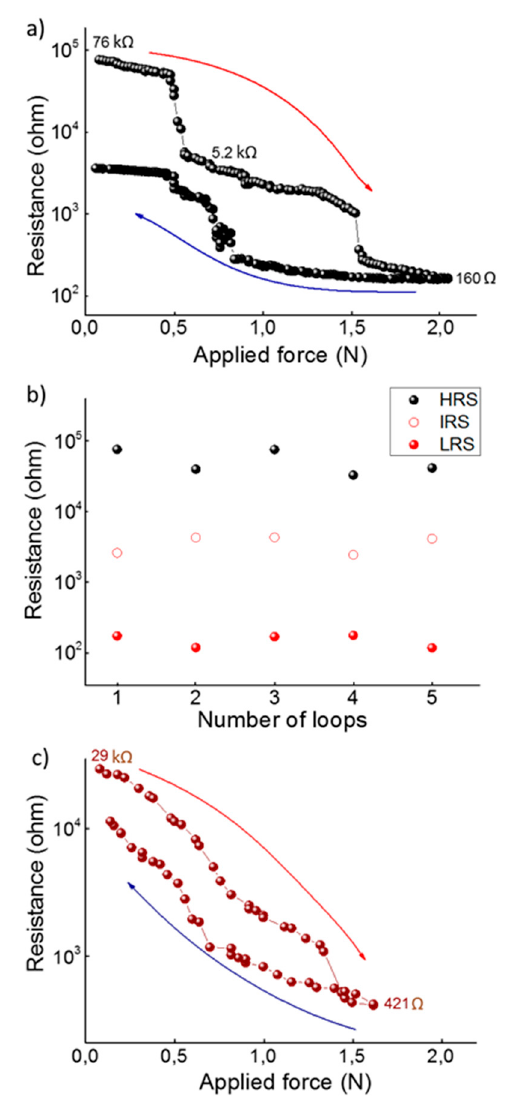
Figure 6. ( a ) Resistance across the SmS/EuS/SmS (35/30/35 nm, deposited at 250 °C) tri-layer, upon applying force up to 2 N. Red arrow for increasing force, the navy arrow when unloading. ( b ) Resistance value for five consecutive cycles of loading and unloading, at a force of 0.05, 0.9 and 1.6 N (corresponding to the high (HRS), intermediate (IRS) and low (LRS) resistance state) during the loading phase of the cycles. ( c ) Resistance of a thin film tri-layer with the same composition, deposited at 400 °C.